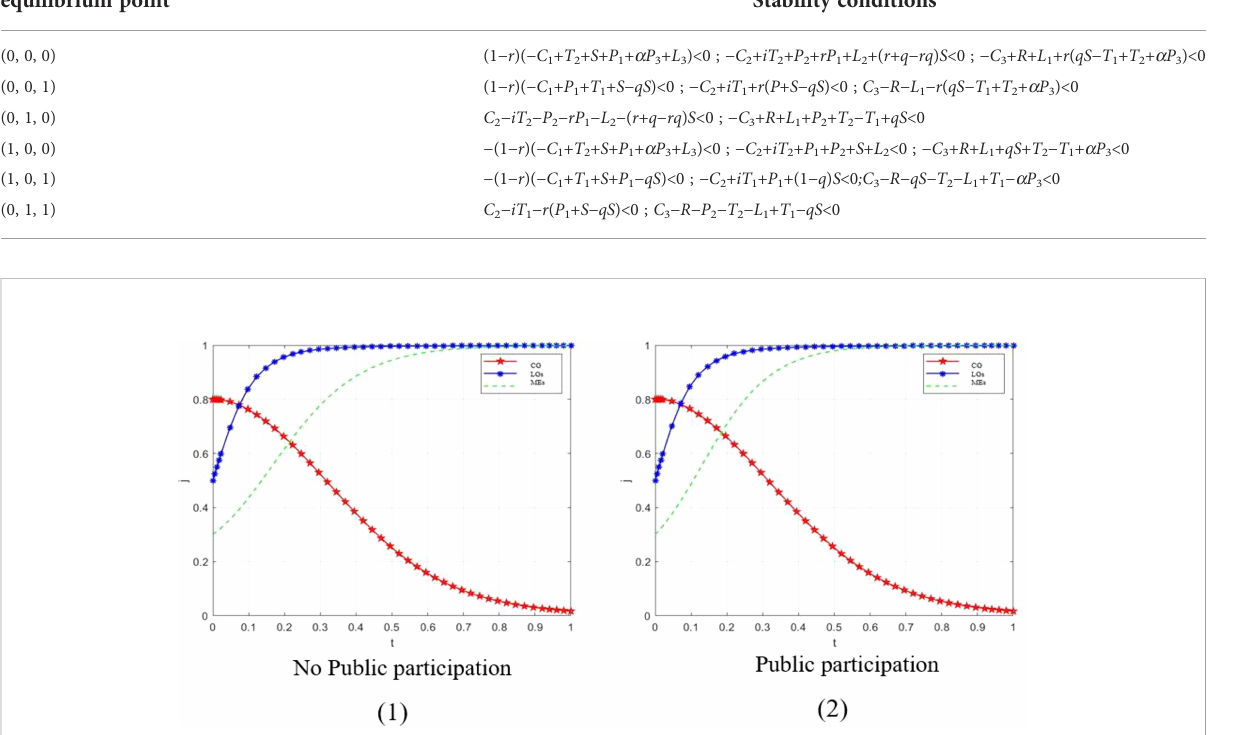
TABLE 5 Stability conditions for the equilibrium point under public participation.